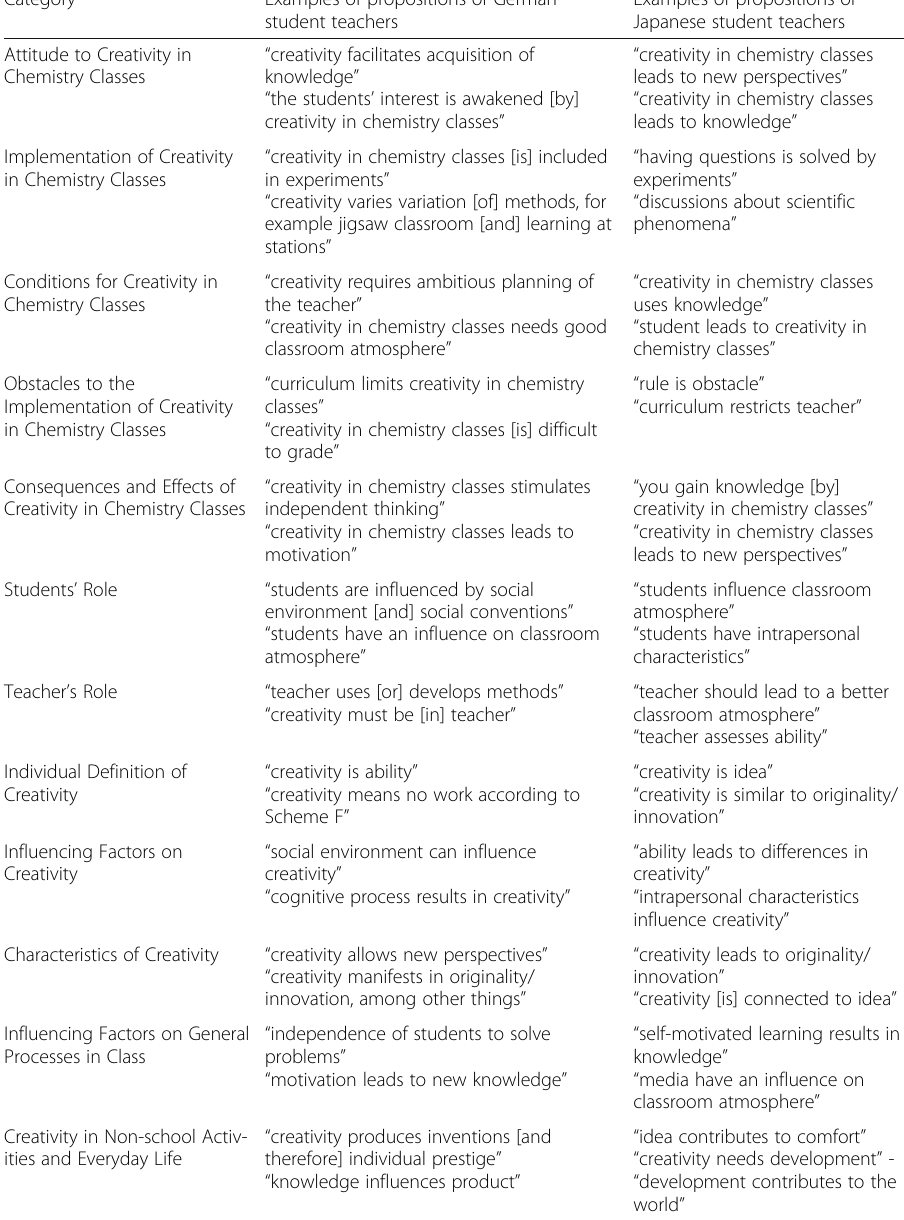
Table 6 Examples of propositions of German and Japanese student teachers (the authors added terms in brackets to make the meaning of the propositions clear)